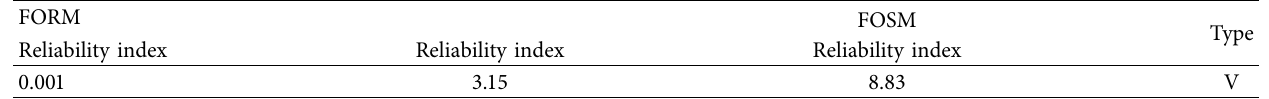
Table 10: Results of reliability analysis of five-layer chilled steel frame by RT